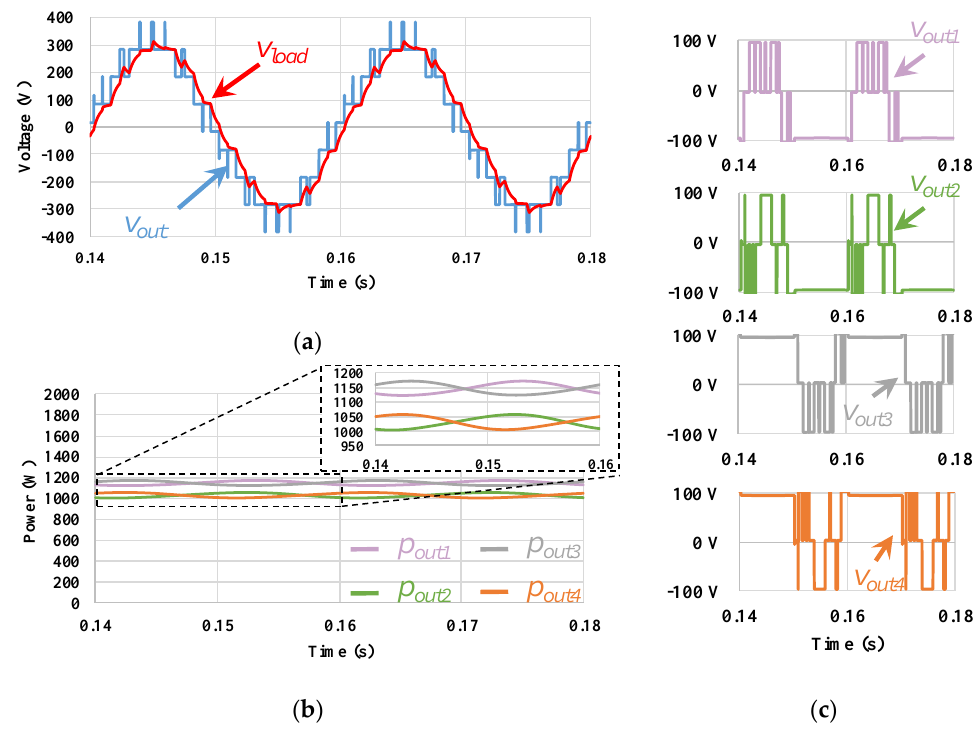
Figure 17. Simulation results of the balanced POD PWM technique: ( a ) output voltage of the cas- caded MLC, v out , and load voltage, v load ; ( b ) output power on each submodule ( p out1 , p out2 , p out3 , p out4 ); ( c ) output voltage on each submodule ( v out1 , v out2 , v out3 , v out4 ).